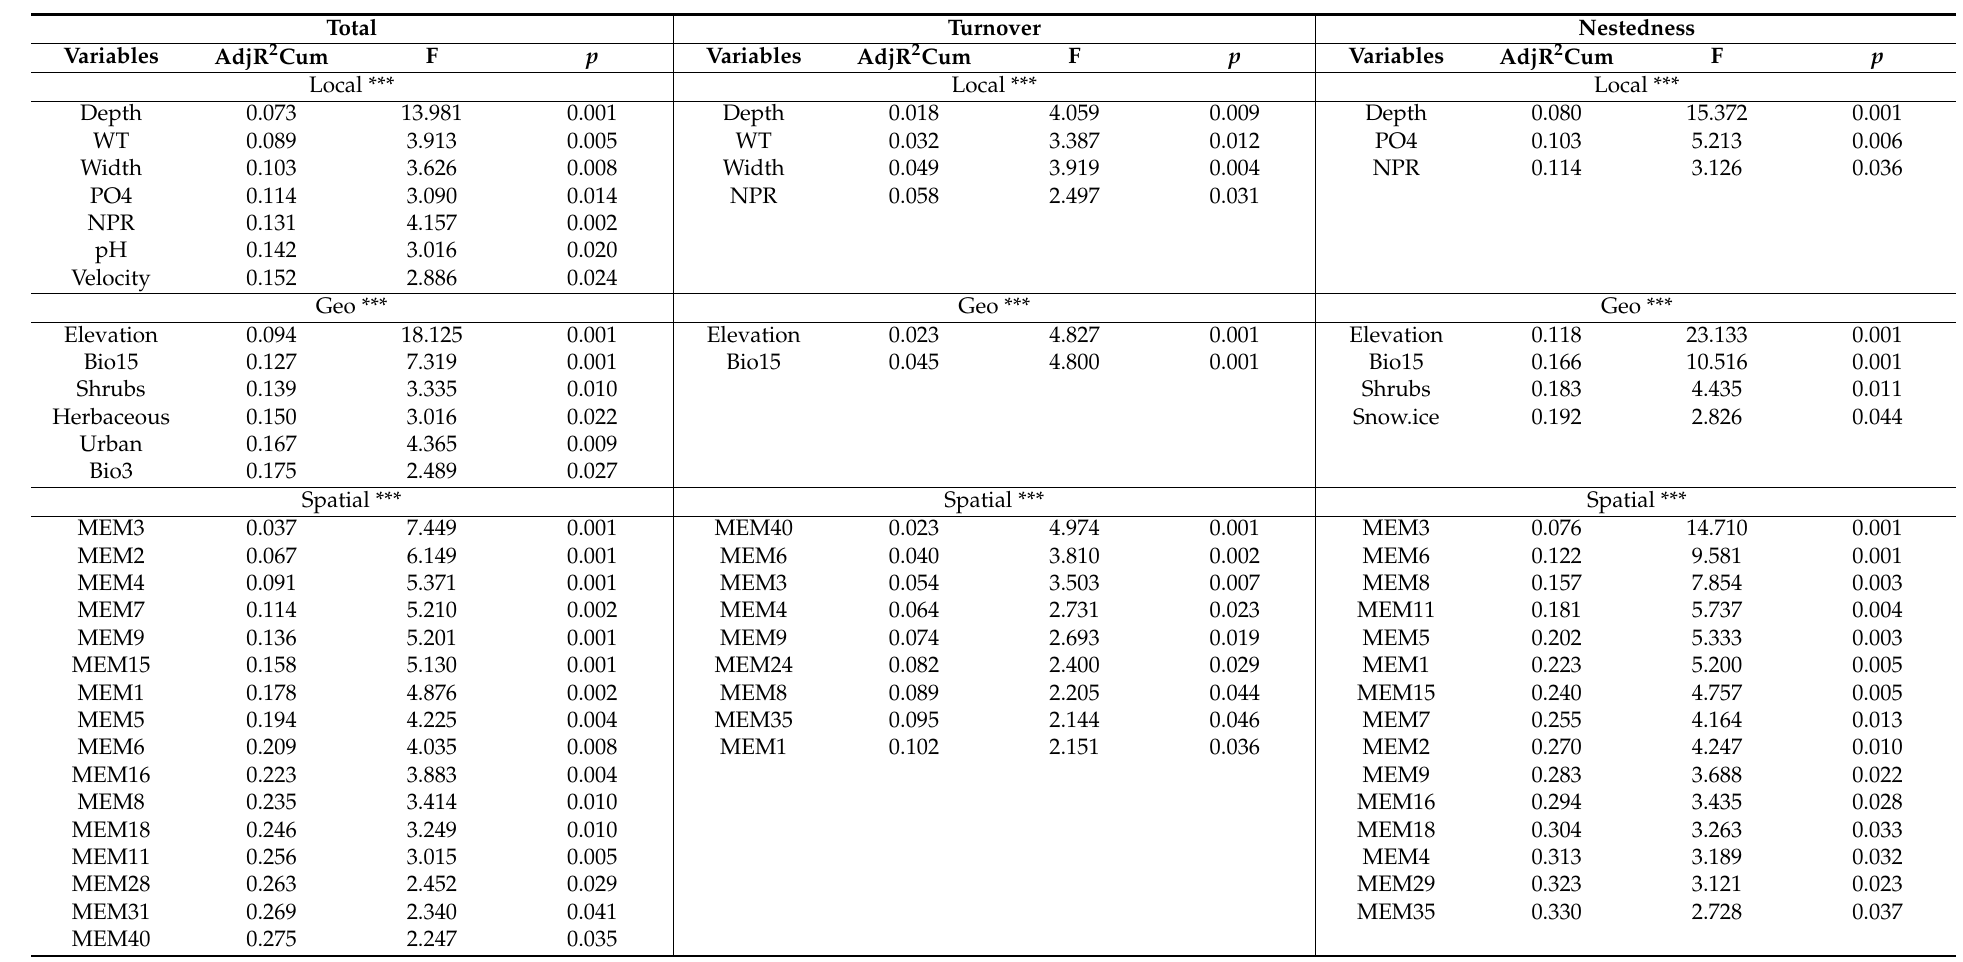
Table 2. The local environmental (Local), geo-climatic (Geo), and spatial (Spatial) variables that were selected for the taxonomic β -diversity component, respectively. Each variable is displayed in the order in which it was selected. F, p, and AdjR 2 Cum values are displayed. None of the selected variables showed